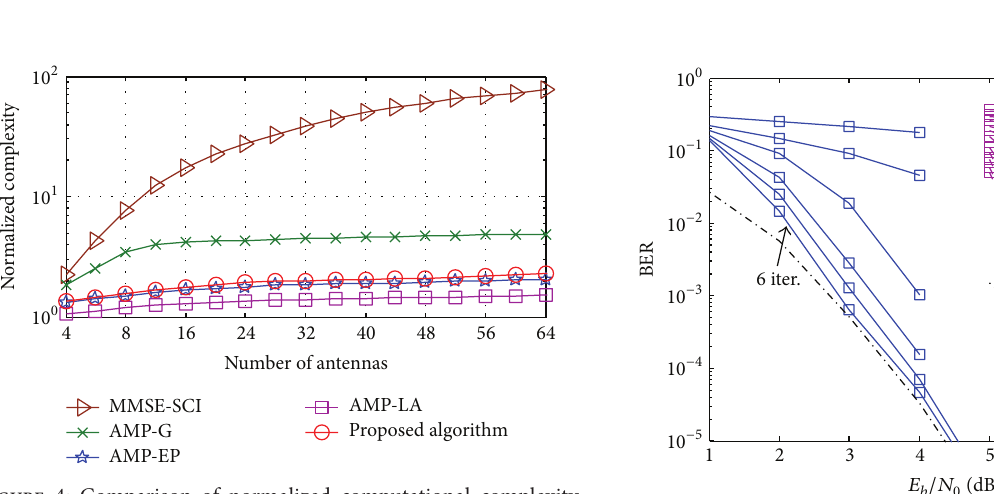
Figure 4: Comparison of normalized computational complexity versus number of antennas.